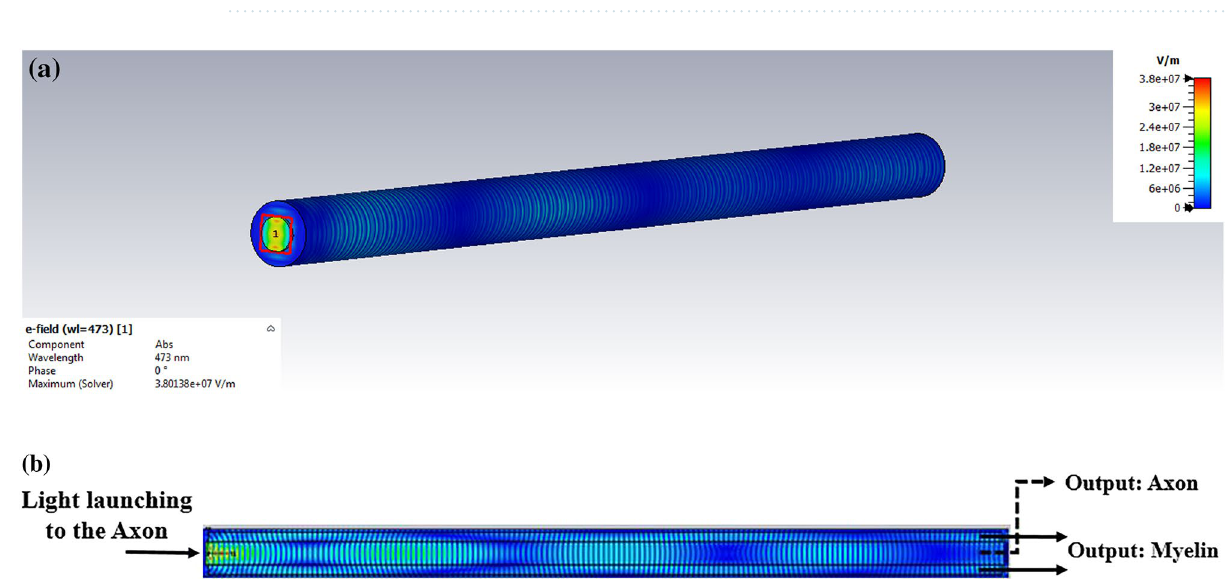
Figure 8. Distributions of electric field when light is launched to the axon, at the ( a ) circular and ( b ) longitudinal cross-sections of the myelinated